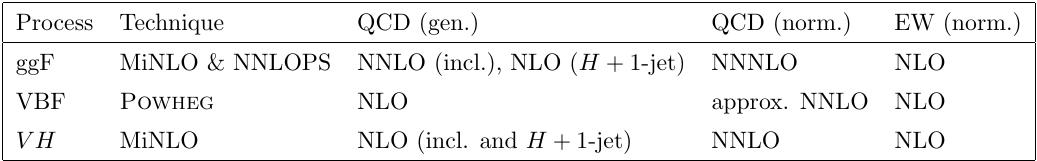
Table 1 . Higgs boson production processes produced with Powheg Box with the techniques used and their precision in (cid:11) s for the event generation (gen.). The total cross section is known with higher precision in QCD and electroweak (norm.) than available in the event generation. The events were reweighted to reproduce the more precise total cross